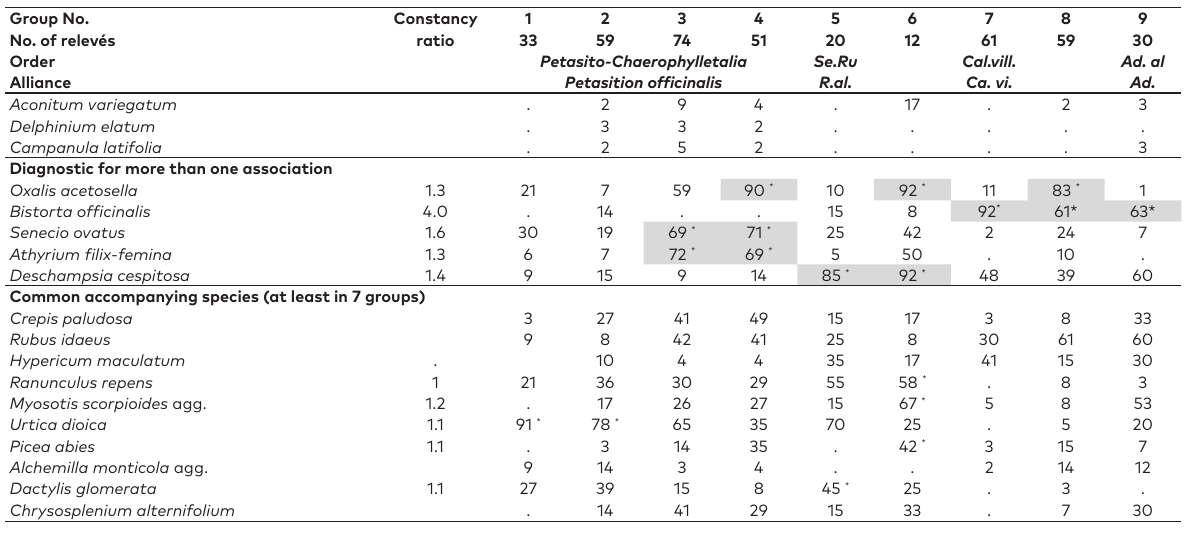
Ecological differentiation